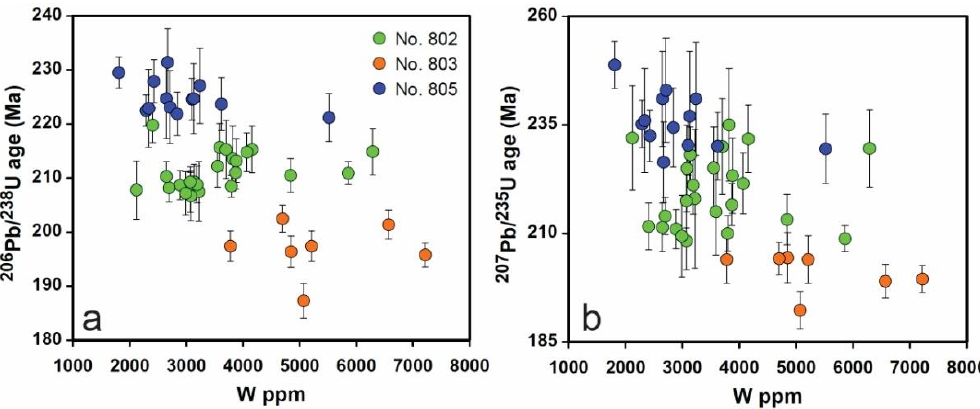
Figure 12. Binary plots showing correlations between columbite LA-ICP-MS U-Pb ages and the W concentrations of CGMs, ( a ) and ( b ) variations in 206 Pb / 238 U and 207 Pb / 235 U ages versus W. The error bars represent the analytical errors (2 σ ) for 206 Pb / 238 U and 207 Pb / 235 U ages.